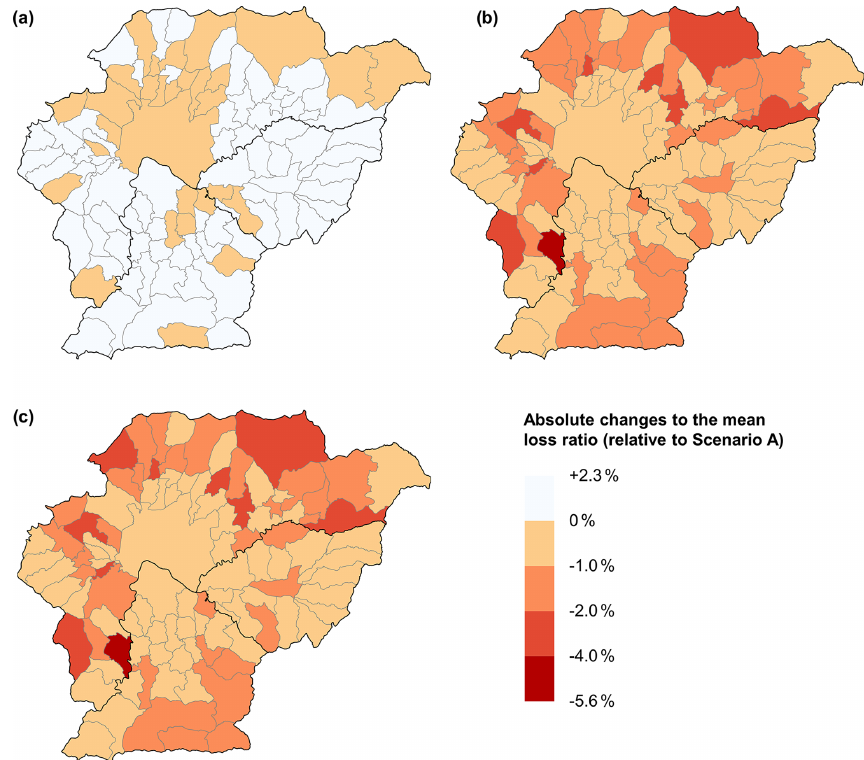
Figure 13. Absolute changes to the municipality-level mean loss ratios for (a) Scenario B, (b) Scenario C, and (c) Scenario D, relative to Scenario A, for the 1000-year flooding